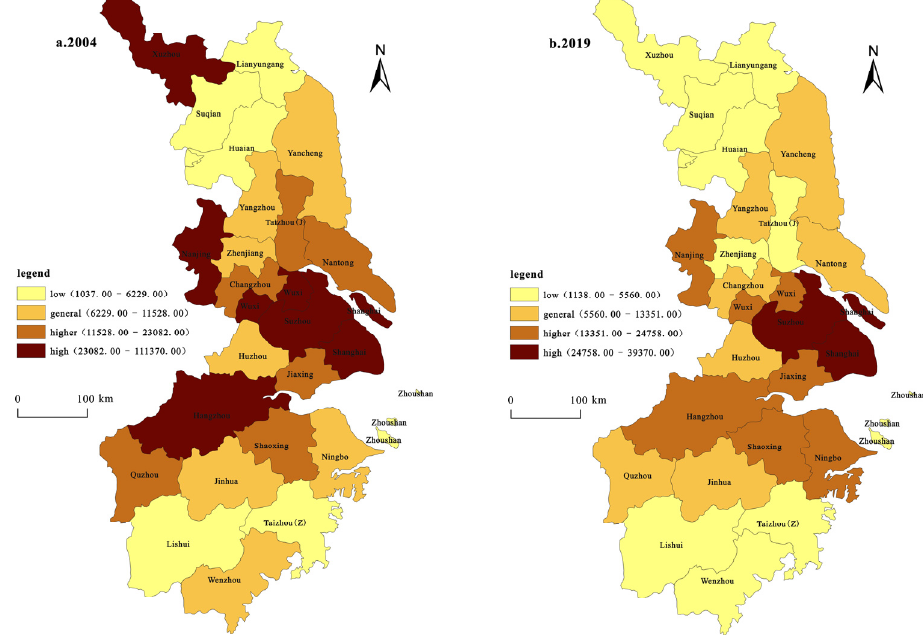
Figure 5. Changes in the spatial pattern of water pollution in the YRD in 2004 and 2019.